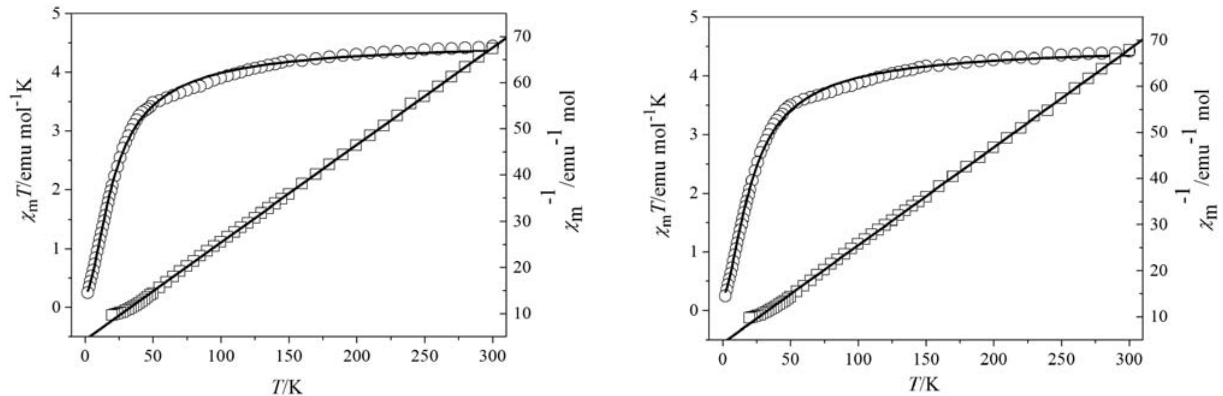
Figure 4. Temperature dependences of χ T - T (the solid line represents the best fit based on the parameters discussed in the text) for complex 1 m –1 -T (the solid line was calculated from the Curie-Weiss (left) and 2 (right). Inset: Temperature dependences χ m